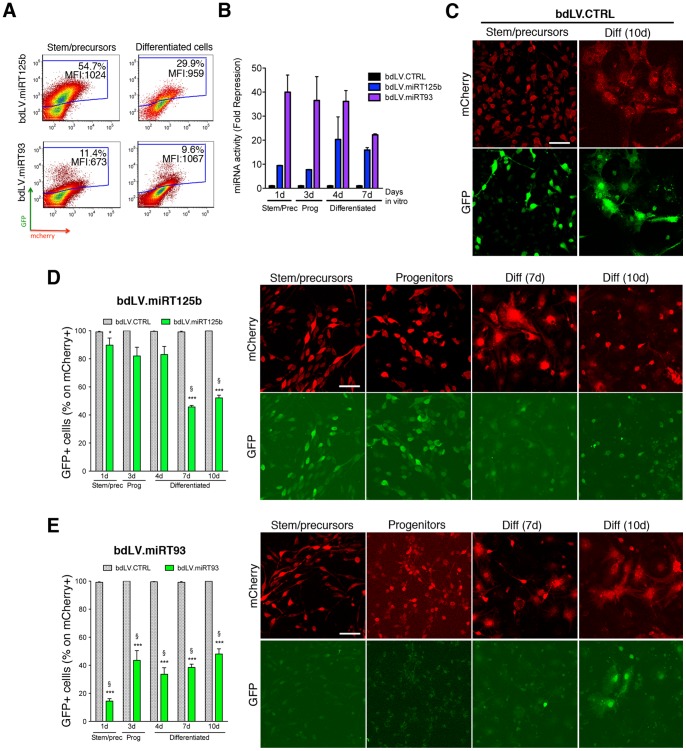
Modulation of miR-125b and miR-93 activity during NSC differentiation.(A) Representative GFP/mCherry expression in stem/precursors transduced with bdLV.miRT93 or bdLV.miRT125b (left), and their differentiated progeny (right). Percentages indicate GFP+ cells. MFI, mean fluorescence intensity of GFP signal. (B) Mean GFP fold repression (FR) measured in bdLV.miRT125b- and bdLV.miRT93-transduced cells as compared to bdLV.CTRL-transduced cells (mean ±SEM; n = 2 independent experiments). Calculations were done as in Figure 2D. (C) Co-expression of GFP and mCherry in bdLV.CTRL-transduced cells. Red, anti-mCherry antibody; green, GFP direct fluorescence. (D) Downregulation of GFP expression indicates increased activity of miR-125b at late stages of NSC differentiation in bdLV.miRT125b-transduced cells. (E) Faint GFP expression in bdLV.miRT93-transduced NSC cultures indicates robust activity of miR-93 in stem/precursor cells that is maintained in ≈50% of cells in progenitors and differentiated cells. Prec, stem/precursors; Prog, progenitors; Diff, differentiated cells; d, days in vitro. Data are expressed as percentage of GFP+ cells on transduced cells (mCherry+). Gray bars represent percentages in bdLV.CTRL-transduced cells. Data are the mean±SEM; n = 2 experiments, 3–5 coverlips/experiment. One-way analysis of variance followed by Bonferroni’s posttest. * p<0.05, *** p<0.001 versus bdLV.CTRL; § p<0.05 versus stem/precursors.